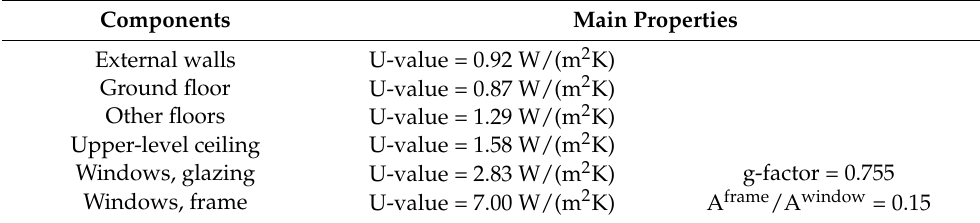
Figure 3. Building street view and floor plan of the first and the second floor. The overall heated and cooled floor area is 1480 m 2, and the ratio between external surfaces and the conditioned volume is 0.81 m 2 /m 3 . The external walls are made of hollow bricks, and there are aluminum double-pane windows. The main thermal properties of the external opaque and the glazed components are listed in Table 2. Table 2. Properties of the main opaque components and